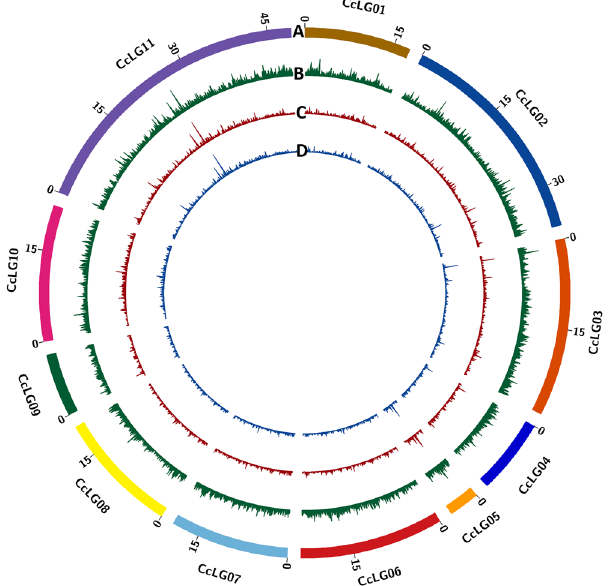
Figure 2. Genome-wide distribution of SNPs identified in ICPL 20096 × ICPL 332 (PRIL_B), ICPL 20097 × ICP 8863 (PRIL_C) and ICP 8863 × ICPL 87119 (F 2 ) populations in pigeonpea. The number of SNPs identified within 100 Kb interval were calculated and plotted as a smooth line curve. The height of the curve is proportional to the number of SNPs within that 100 Kb interval. ( A ) Pigeonpea pseudomolecules, labelled as CcLG01 to CcLG11 and each pseudomolecule is shown in different colour. The numbers on arches represent the scale for the size of pseudomolecule in Mb. ( B ) Genome-wide distribution of SNPs identified in ICPL 20096 × ICPL 332 (PRIL_B) population ( C ) Genome-wide distribution of SNPs identified in ICPL 20097 × ICP 8863 (PRIL_C) population and ( D ) Genome-wide distribution of SNPs identified in ICP 8863 × ICPL 87119 (F 2 ) population in